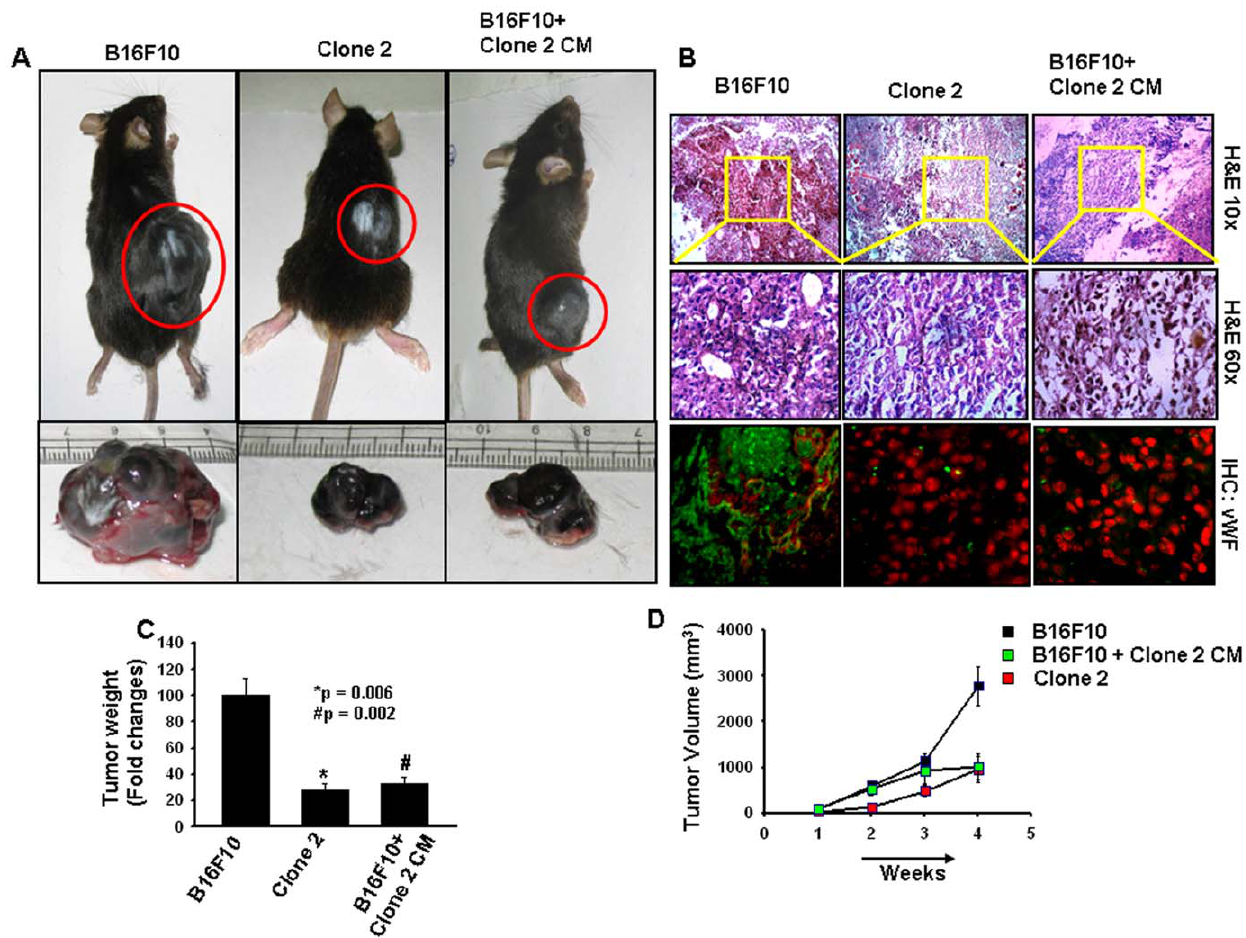
Figure 6. Overexpression of Sema 3A abrogates invivo melanoma growth and angiogenesis in subcutaneous allograft tumor model in C57BL/6 mice. Control B16F10 and clone 2 cells (1 6 10 6 /mice) were injected subcutaneously into the dorsal flank region of male mice (6–8 weeks old; n=6). In separate experiments, serum free conditioned media (CM) collected from clone 2 cells were injected intratumorally twice a week to the tumors generated by B16F10 cells upto termination of the experiments (n=6). Mice were sacrificed after 4 weeks. (A) Typical photographs of subcutaneous melanoma in C57BL/6 mice and excised tumors of respective mice were shown. (B) Mice allograft tumors were analyzed by histopathology and immunohistochemistry using anti-vWF antibody. vWF was stained with Cy2 (green) whereas nuclei were countered stained with PI (red). (C) Weight of the excised tumors were measured, analyzed and represented in the form of bar graph (*p=0.006, # p=0.002). (D) Tumor volumes of the allograft melanoma tumors were measured weekly, analyzed and plotted graphically. Six mice were used in each set of experiments.